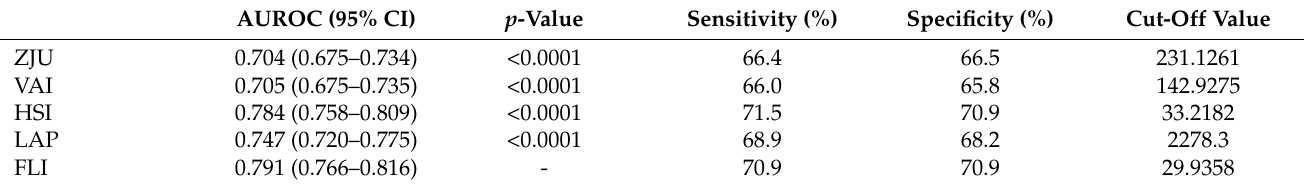
Table 4. Sex differences in the diagnostic accuracy of ZJU, VAI, HSI, LAP, and